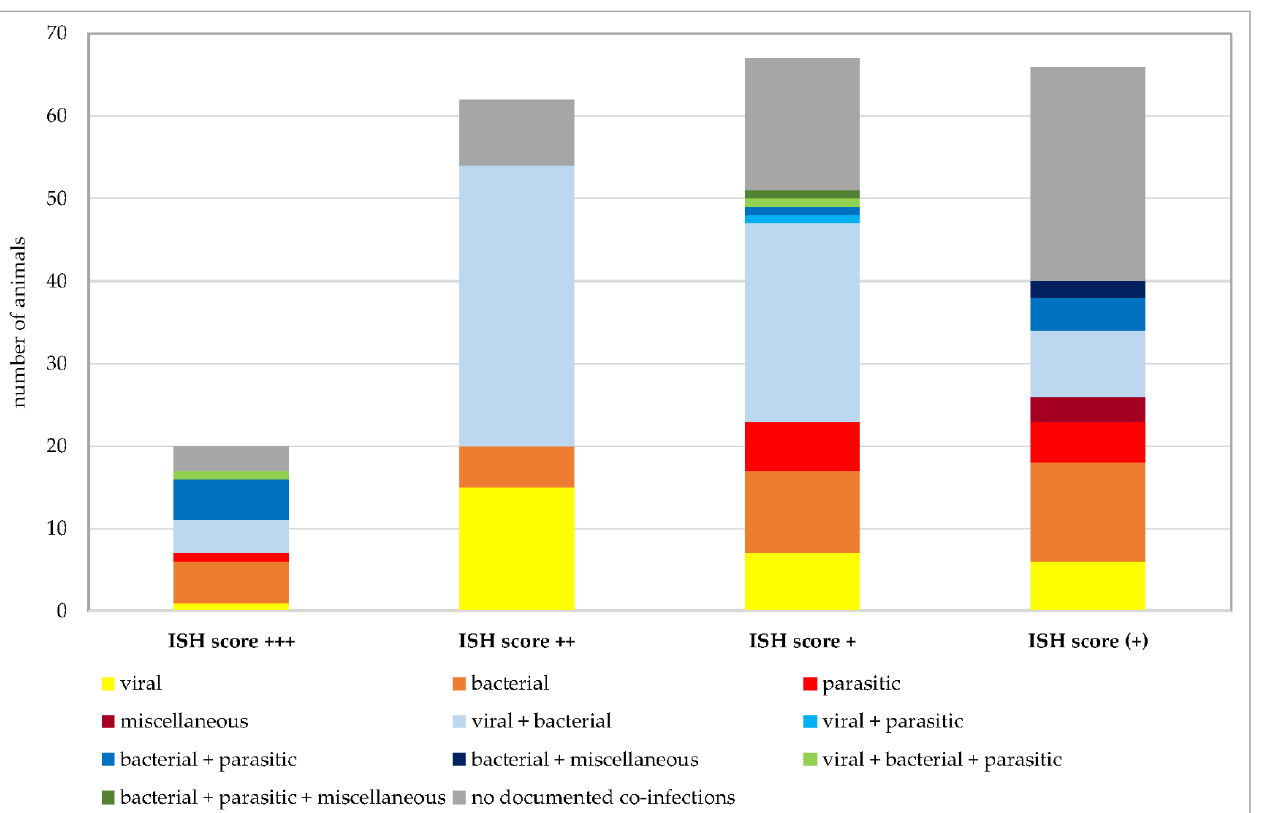
Figure 12. Number of Pneumocystis -positive samples broken down to the ISH scores +++ (multiple signals), ++ (moderate signals), + (few signals), and (+) (minimal signals). Animals positive for exclusively viral, bacterial, parasitic, or miscellaneous pathogens are shown in shades of yellow to dark red. Animals positive for combinations of two of these categories are shown in shades of blue and combinations of three of them in shades of green. Animals without documented co-infections are shown in gray.